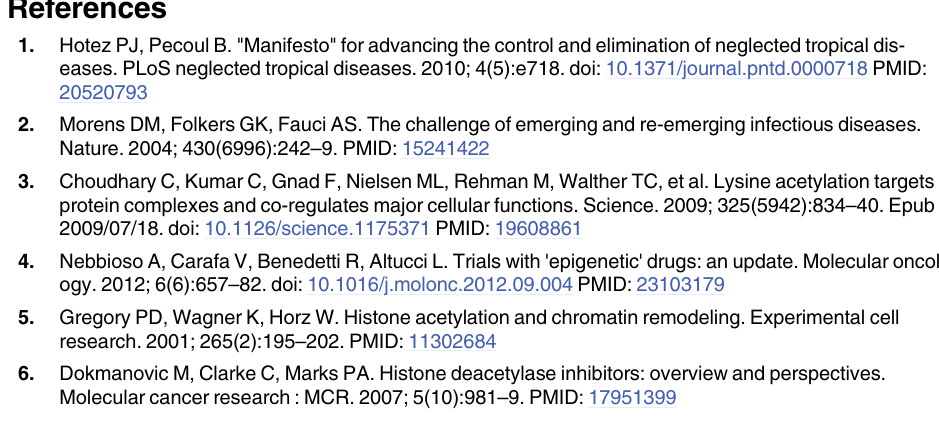
S1 Fig. Compound MC2780 docked to the KDAC1 protein of P . falciparum . MC2780 is shown as grey stick model along with important residues for ligand binding as Fig 5. (TIFF) S2 Fig. Sequence alignments of all the KDAC1 proteins of parasitic species within the fam- ily, along with the sequence of H . sapiens . Active-site residues (within 10 Å distance to cata- lytic zinc atom) in the crystal structure (4BKX, chain B) are marked as “ + ” underneath. Any variant residues within the parasitic species are marked as “ (cid:4) ” at the bottom. (TIF) S1 Table. Sequence identity and similarity between each parasite species target and the tem- plate (human) structure, as well as the RMSD values in each step of the modeling process. (XLSX) S1 Supporting Materials. A compressed file containing protein data bank-format file for the top 5 scoring poses of docked ligands to the KDAC1 structures for the 4 species ( H .